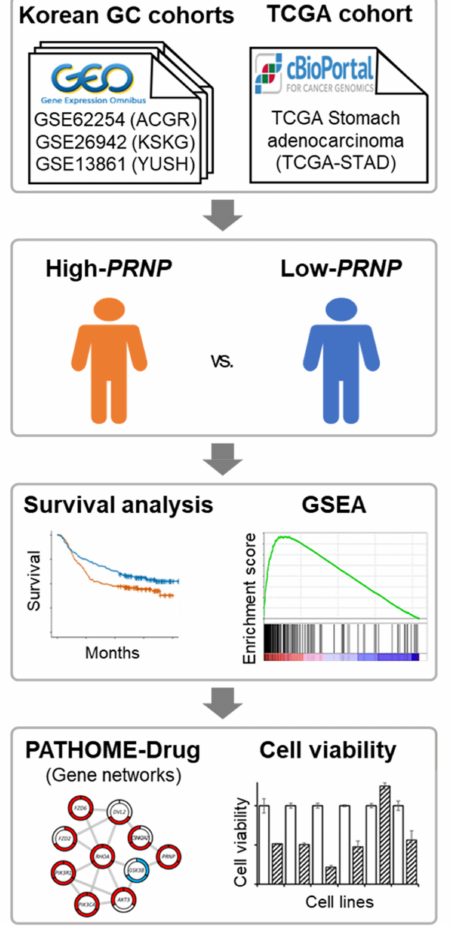
Figure 1. Overview of the study. Three cohorts of Korean GC patients were collected from GEO and divided into “high- PRNP ” and “low- PRNP ” groups. To confirm the association between the expres- sion level of PRNP and GC prognosis, survival analysis, GSEA, network analysis, and knockdown experiments were